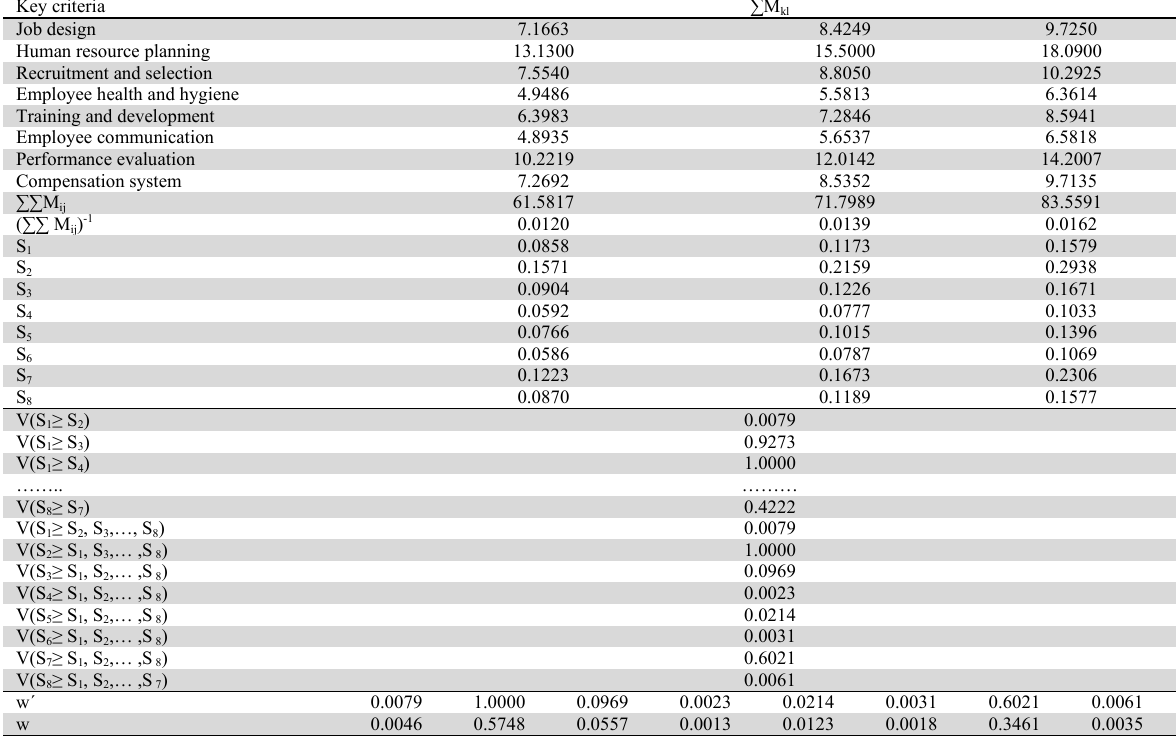
Summary of calculations and prioritization of key criteria